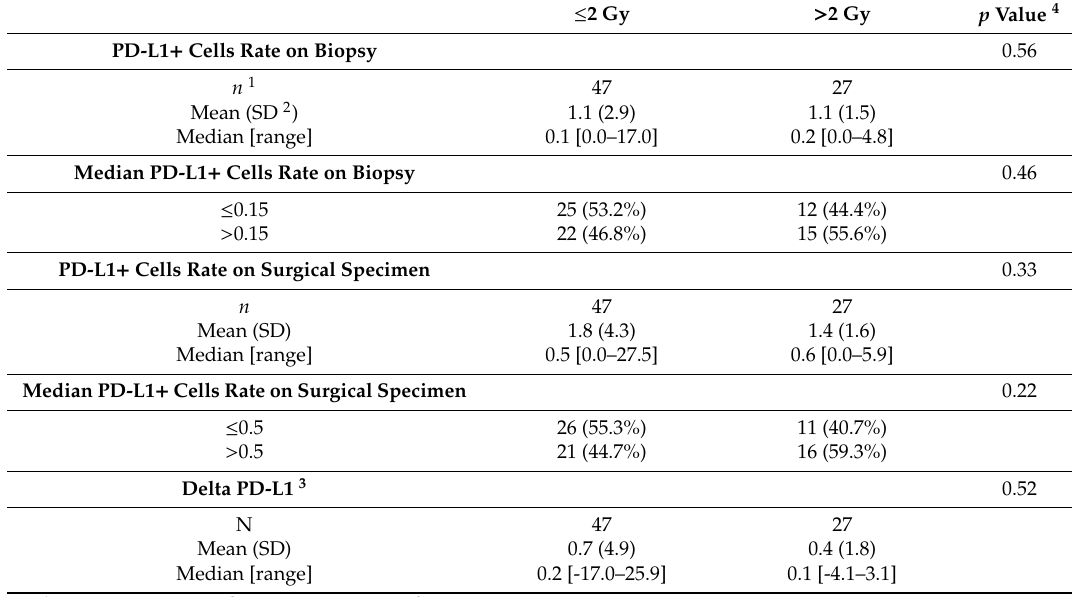
Table 2. Comparison of PD-L1 + cells rate according to short-course ( > 2 Gy) and long-course radiotherapy ( ≤ 2 Gy).